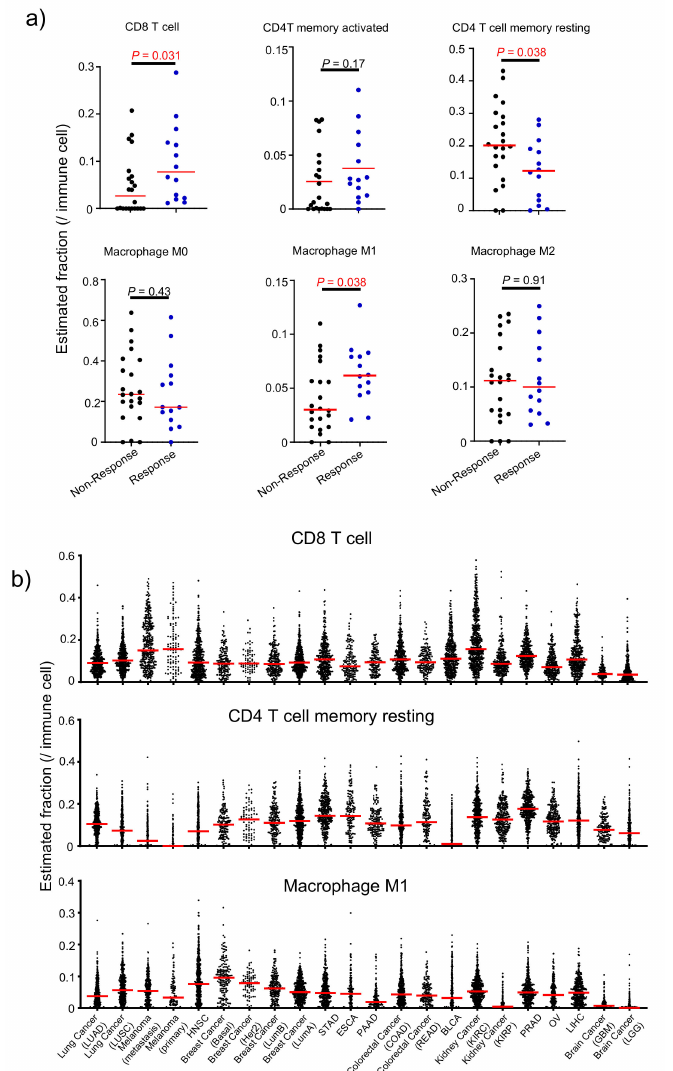
Figure 5. Estimated immune cell fraction varied across cancers from TCGA. ( a ) Distribution plot of estimated immune cell fraction among anti-CTLA-4 therapy responders and non-responders. Those that show significant association were used to rank human cancers. ( b ) Distribution plot shows selected estimated immune cell fractions across 22 cancer types from TCGA. Those parameters that are significantly associated with CTLA-4 response in ( a ) were chosen to rank the 22 cancer types in ( b